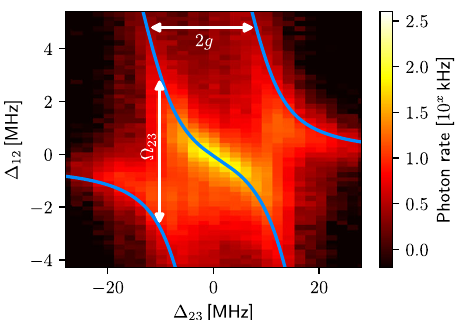
Fig. 2 System spectroscopy. The emitted rate of photons from the cavity versus the detunings Δ 12 and Δ 23 in logarithmic scale. The blue lines in the fi gure are the theoretically calculated energies of the one-photon states for the ideal system. Also marked are the splittings between these eigenenergies, which are 2 g in horizontal and Ω 23 in the vertical direction. The experimental Rabi frequencies are Ω 23 /2 π = 4.0 MHz and Ω 12 /2 π = 0.4 MHz with a coupling constant g /2 π = 10.2 MHz.